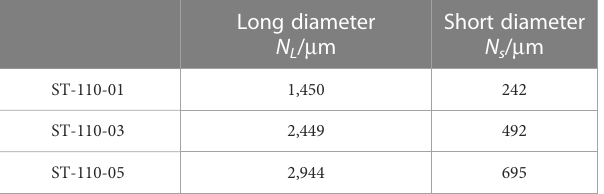
TABLE 1 Structural parameters of different nozzle exits.